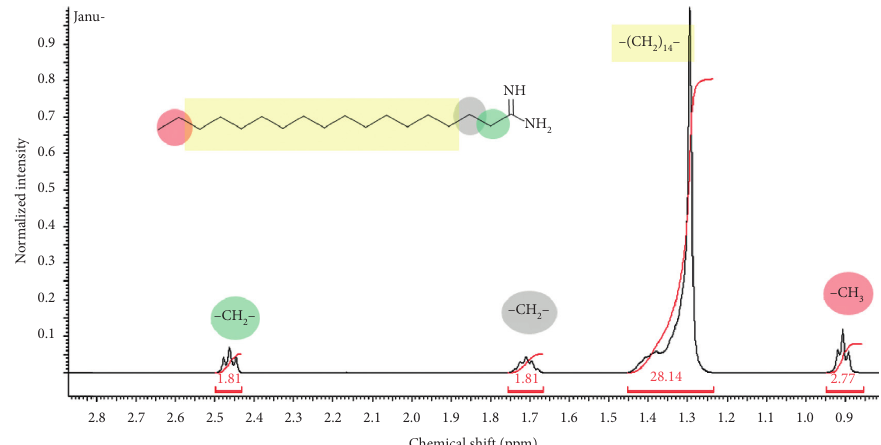
Figure 2: Proton NMR spectra of the product. Inhibition performance: potentiodynamic polarisation and SEM imaging.